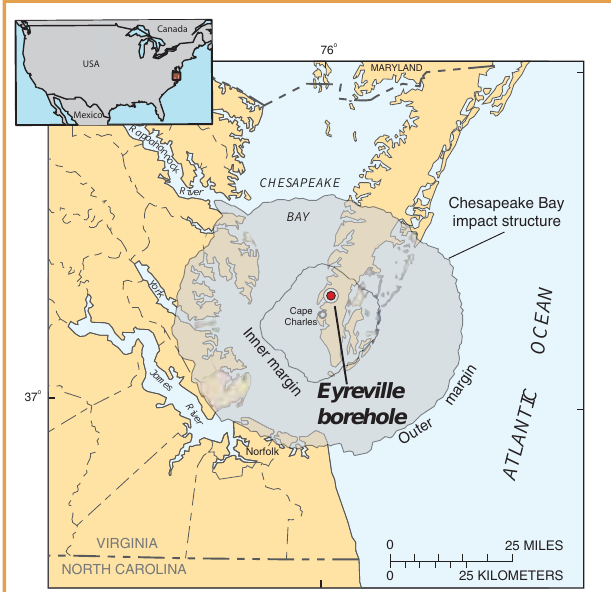
Figure 1. Map showing location of Eyreville drilling site in Chesa- peake Bay impact